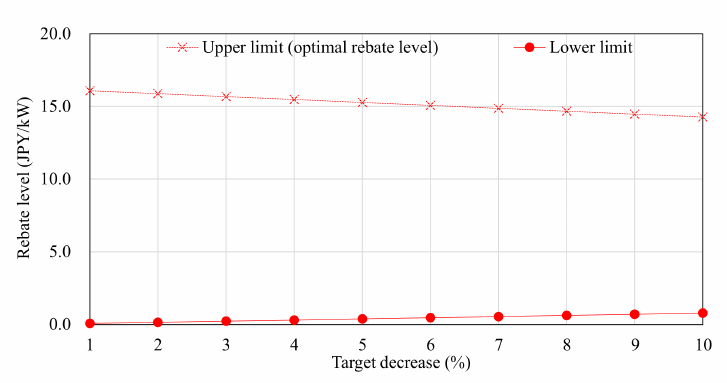
Figure 13. Results on the typical time slots in scenario 1 (at 22:00).